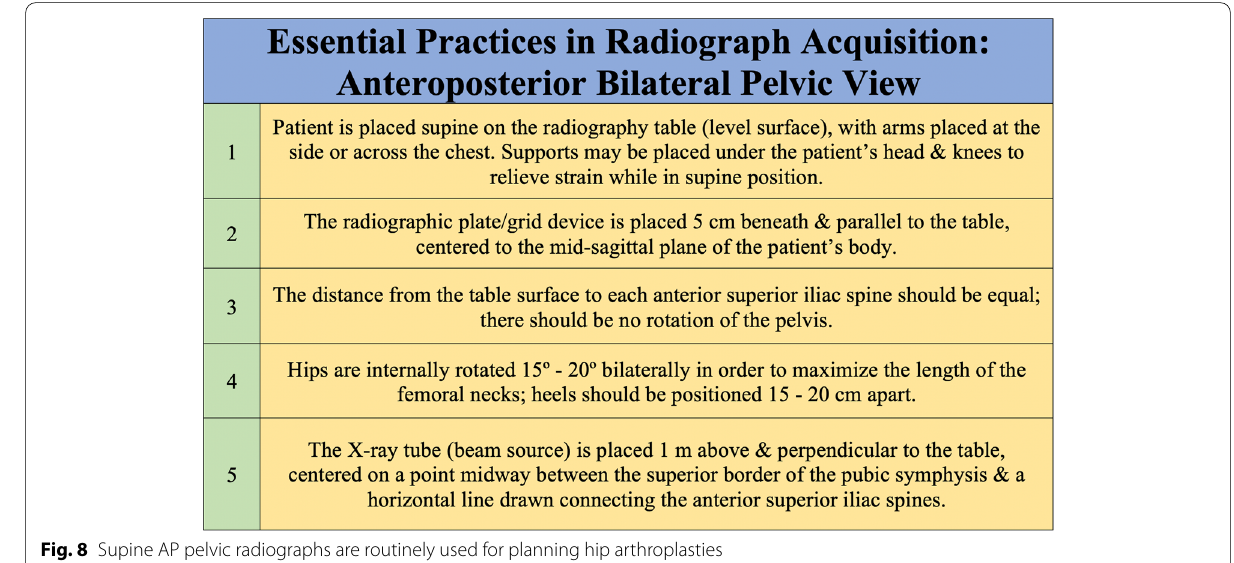
Fig. 8 Supine AP pelvic radiographs are routinely used for planning hip arthroplasties The most crucial aspects of proper radiograph acquisition for this projection are described, with special focus on patient and equipment positioning. We focus on supine rather than standing AP pelvic radiographs given the practical considerations relevant to performing THA -- supine radiographs can be compared directly to pelvic radiographs captured intra-operatively or at early follow-up when the patient may have restricted weight